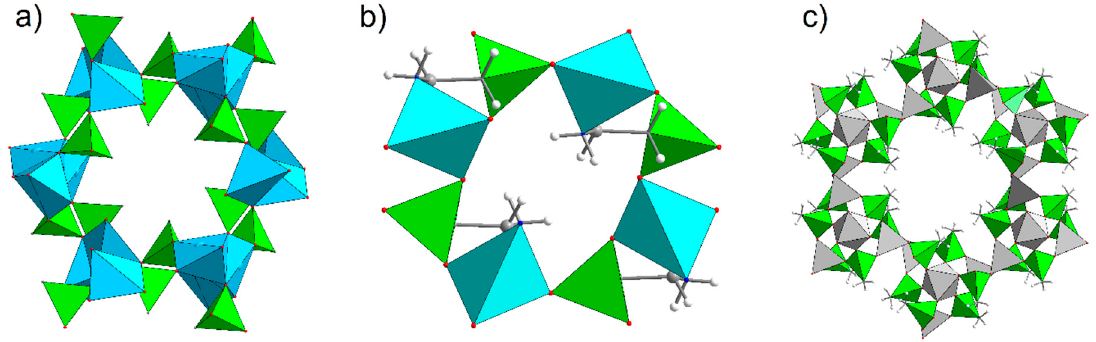
Figure 5. Crystal structures of the open framework metal phosphonates (MPs): ( a ) β -Cu(CH 3 PO 3 ), ( b ) Zn(O 3 PC 2 H 4 NH 2 ), and ( c ) α -Al 2 (O 3 PCH 3 ) 2 . Colour code: light blue: copper, turquoise: zinc, light grey: aluminium, green: phosphorus, red: oxygen, blue: nitrogen, grey: carbon, white: hydrogen.